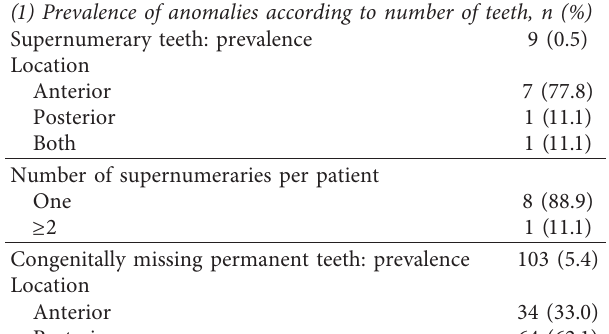
Table 2: Prevalence and distribution of anomalies according to teeth number, shape, and location among children ( N � 1897). (1) Prevalence of anomalies according to number of teeth, n (%)